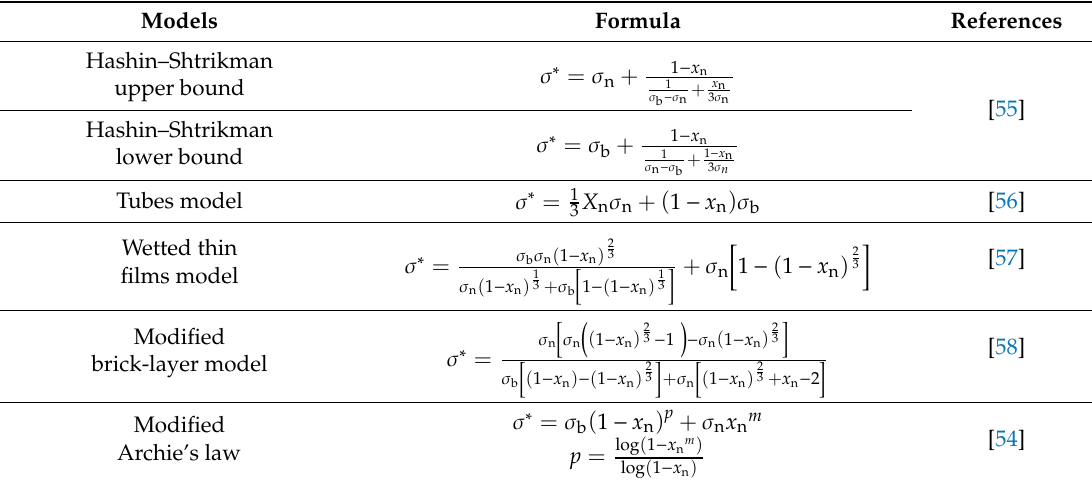
Table 1. Various models to compute electrical conductivity in Figure